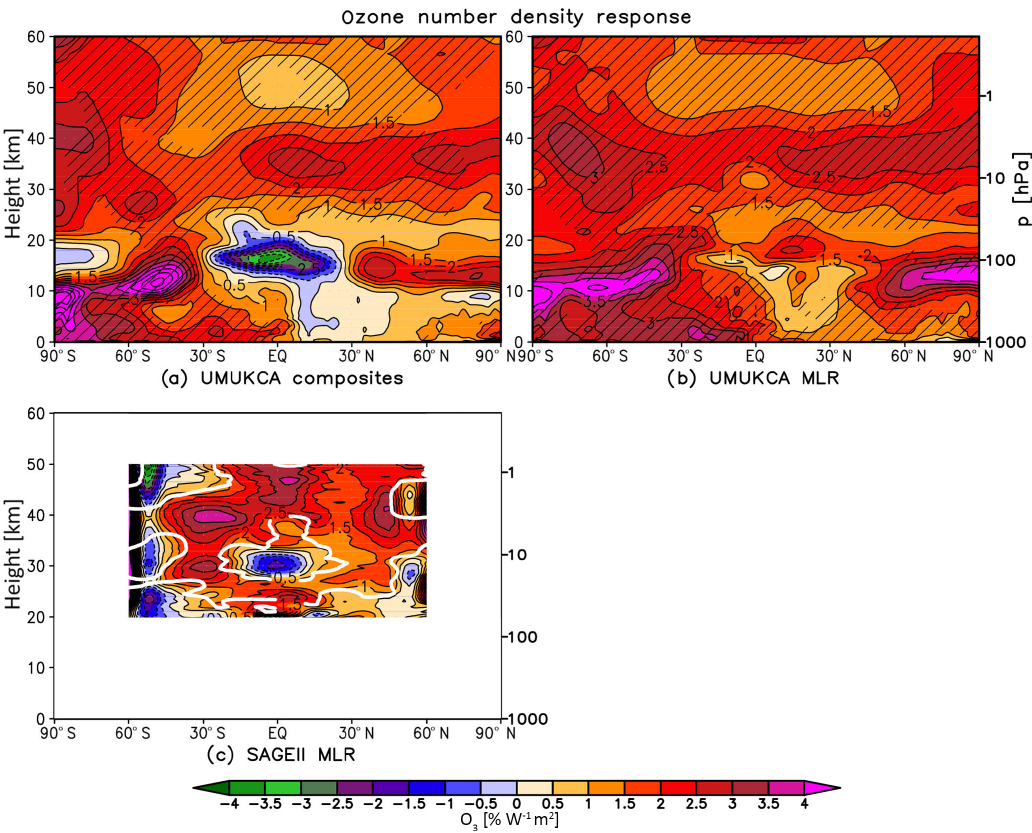
Figure 5. Yearly mean zonal mean ozone number density response (%W − 1 m 2 ) in UM-UKCA derived using composites (a) and MLR (b) , as we all as in SAGE II derived with MLR (c) . The percentages are calculated relative to the mean over the 1966–2010 (a, b) and 1985– 2004 (c) periods. Hatching in (a, b) as in Fig. 3. The thick white line in (c) encompasses regions where the statistical significance exceeds the 95% confidence level. Contour spacing is 0.5%W − 1 m 2 up to ± 7%W − 1 m 2